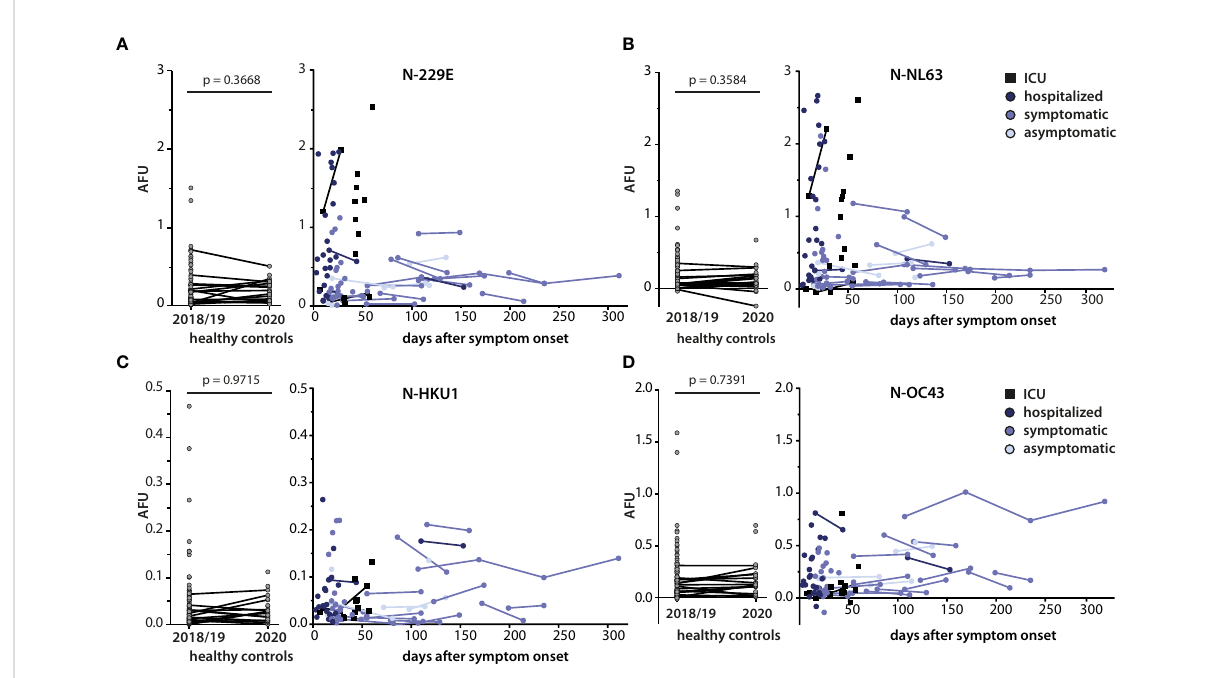
FIGURE 4 Kinetics of IgG responses against N of endemic coronaviruses and association with disease severity. Antibody responses against N of endemic coronaviruses 229E (A) , NL63 (B) , HKU1 (C) , and OC43 (D) were measured in sera of SARS-CoV-2 infected donors (n=84, total time points n=108), in sera of healthy controls collected before the pandemic (2018/2019, n=104), and in sera of a partly overlapping set of healthy controls (n=30) collected during the pandemic (2020, left graphs). SARS-CoV-2 infected donors were grouped according to disease severity. Results are plotted relative to the time of symptom onset (day 0). Individual lines connect serial measurements in the same individual. Mann-Whitney U test was used to compare IgG responses in the two healthy control